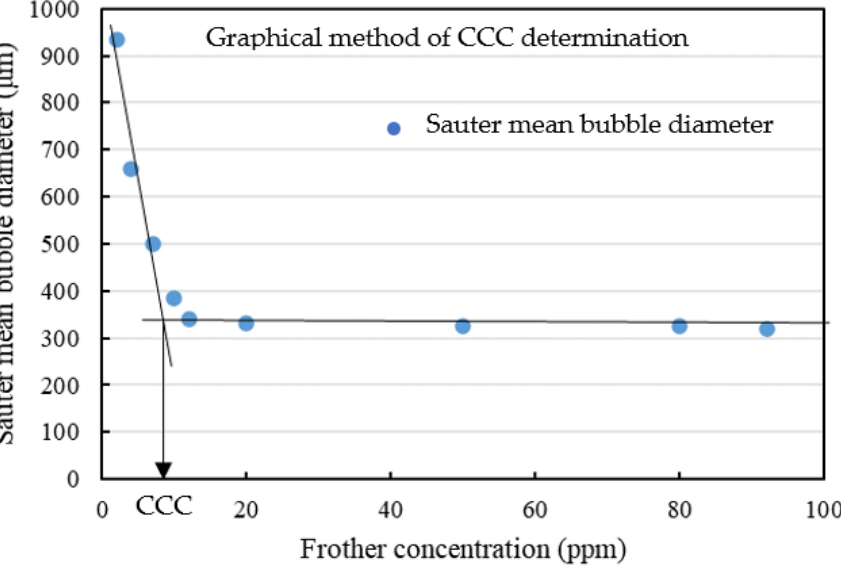
Figure 10. Example of CCC determination.